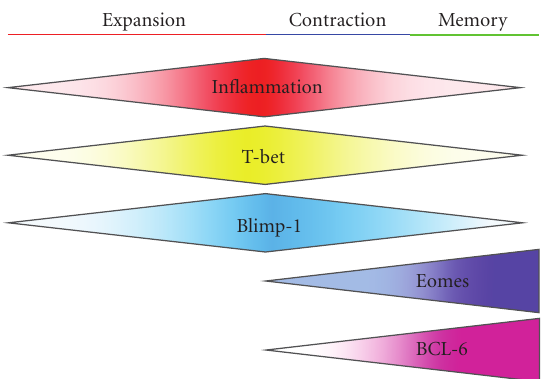
Figure 3: Expression of transcription factors in CD8 T cells is pos- itively or negatively correlated with an inflammatory environment.